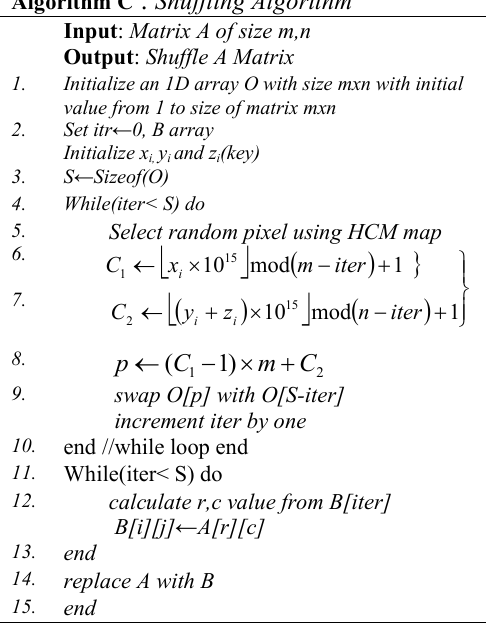
Fig 7. The Steps of Shuffling